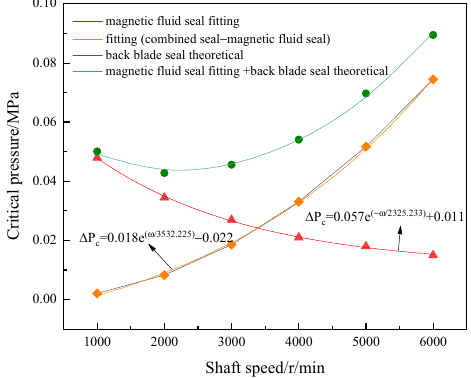
Figure 12. Pressure resistance at different shaft speeds.